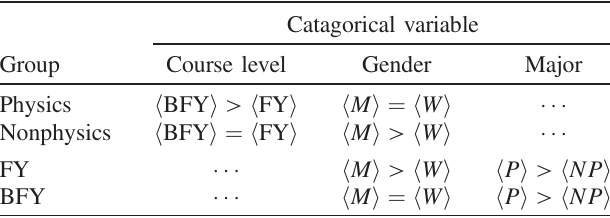
TABLE IX. Impact of each categorical variable on postinstruc- tion means as adjusted by the three-way ANCOVAs. Adjusted means for each variable are calculated controlling for preinstruc- tion score and the other relevant categorical variable, as described in the text. A difference between group means is indicated only when that difference was statistically significant. Here, h P i is the predicted postinstruction mean for physics students, and